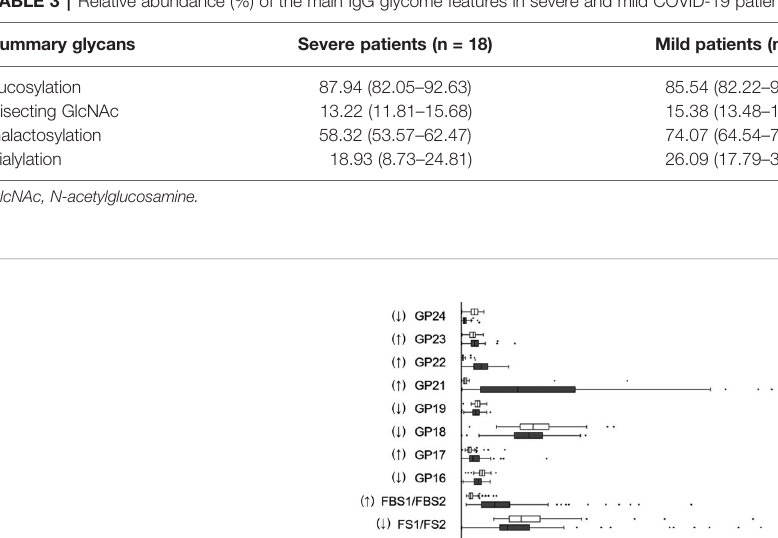
TABLE 3 | Relative abundance (%) of the main IgG glycome features in severe and mild COVID-19 patients.